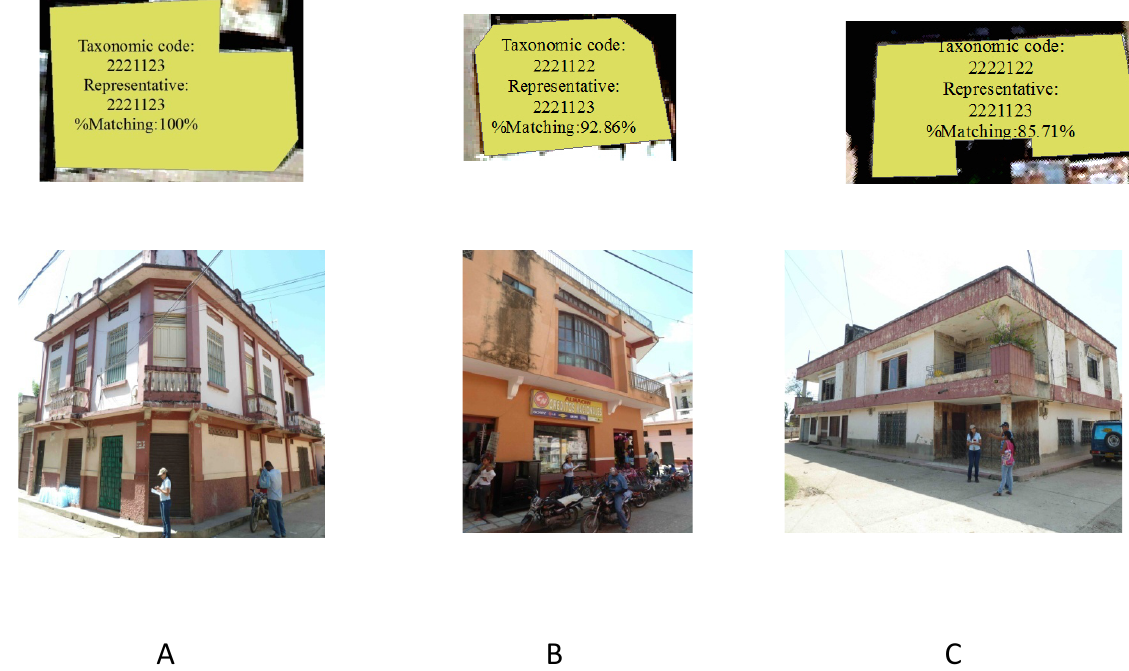
Figure 4. Representative buildings of the taxonomic code “2221123” in Figure 4: Representative buildings of the taxonomic code ‘2221123’ in Magangué